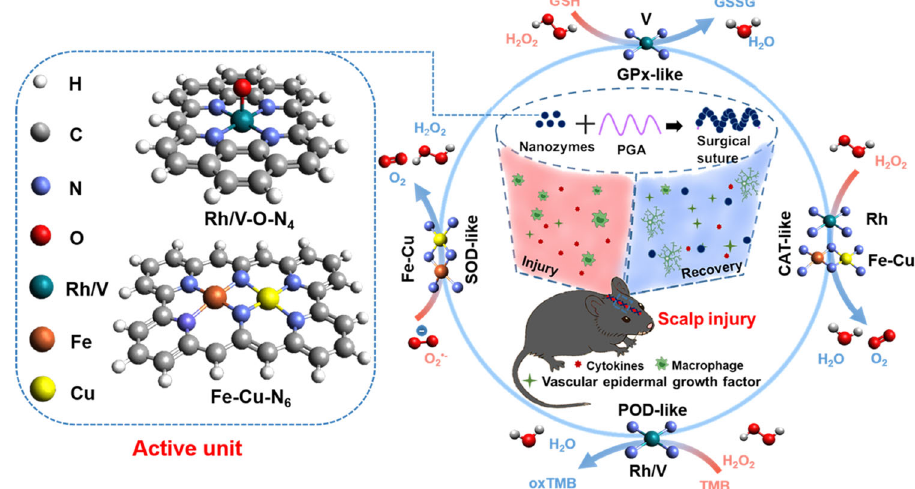
Fig. 1 | Single-atomic nanozymes with superior catalytic activities and selec- tivity beyond the natural enzymes were developed with unique de fi nitive units. The bioactive sutures based on arti fi cial enzymes showed catalytic